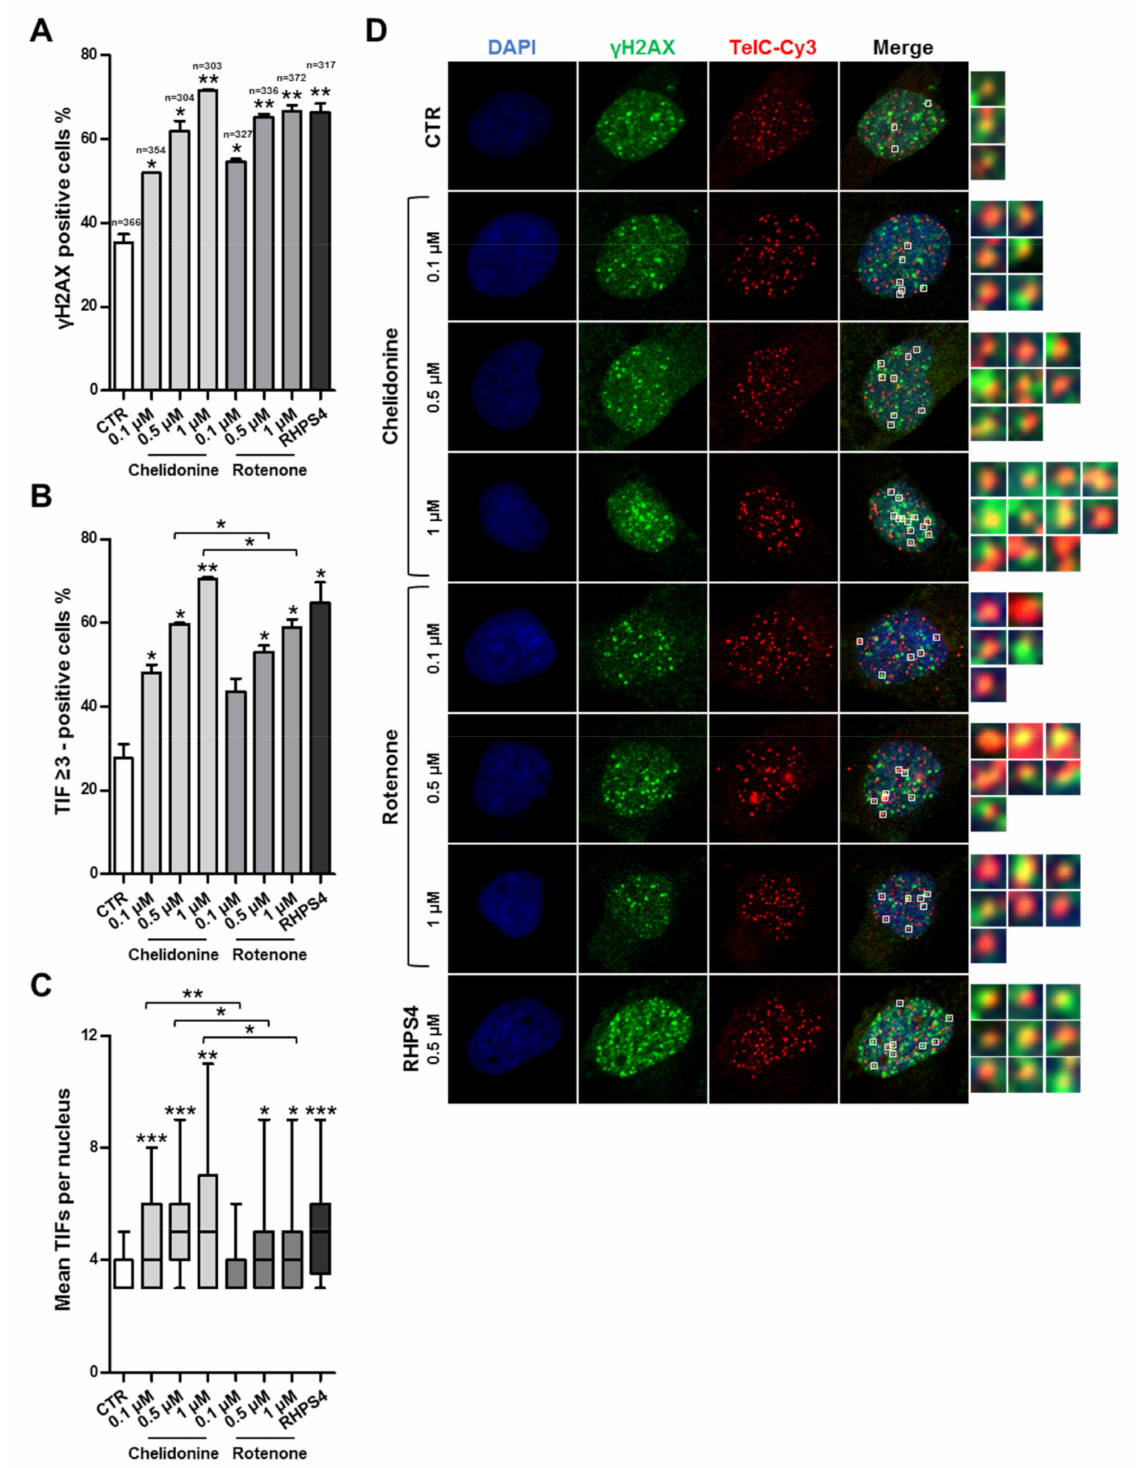
Figure 7. Chelidonine and Rotenone induce telomeric DNA damage. Quantitative analyses of data obtained by FISH. ( A ) Dose-dependent increase in γ H2AX-positive cells. ( B ) Percentage increase in co-localizations between γ H2AX and telomeric probe (TIFs) per nucleus. ( C ) Mean number of TIFs per nucleus. ( D ) Representative immunofluorescence microscopy images. Enlargements of co-localization spots (in yellow). ns, p > 0.05; *, p < 0.05; **, p < 0.01; ***, p <